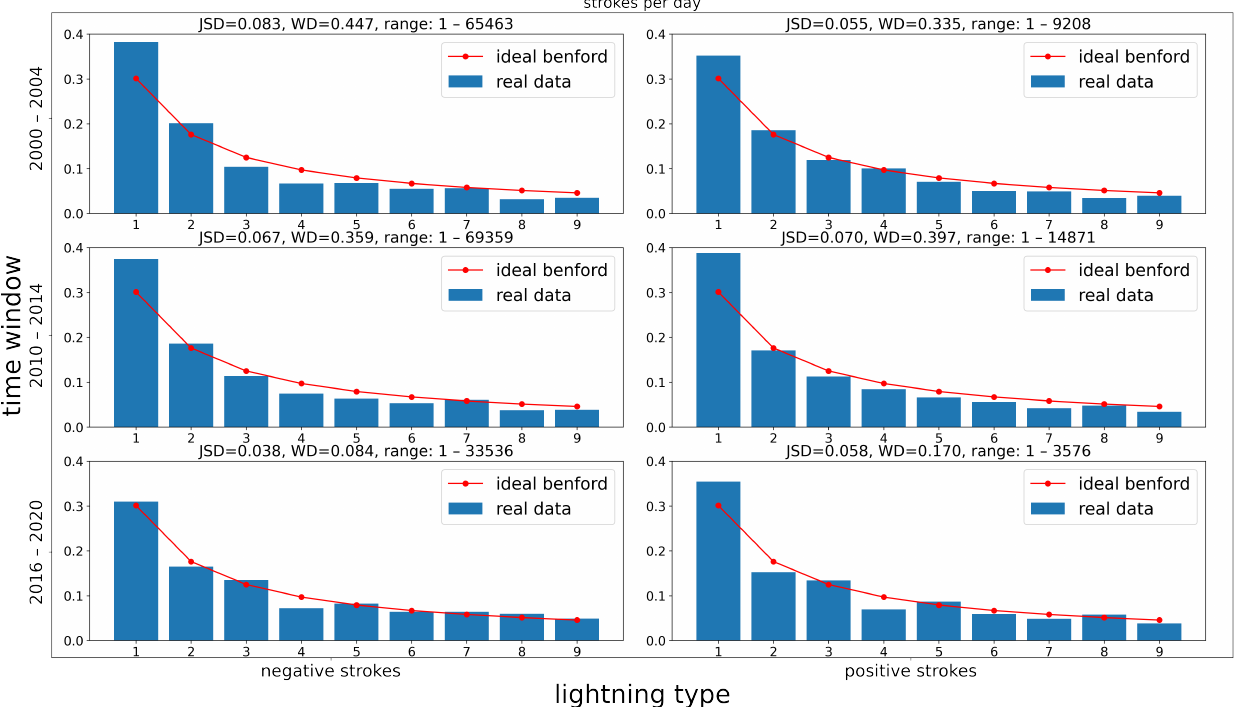
Figure 5. First digit distribution of data versus Benford. These figure show the frequency of the most significant digit of lightning data in blue compared to the expected probability distribution dictated by Benford’s law in red. The left column depicts the negative strokes data and the right one represents the positive ones. Furthermore, rows represent the three time windows, from top to bottom : 2000– 2004, 2010–2014, 2016–2020. Jensen–Shannon distance (JSD), Wasserstein distance (WD), and range of data is provided on the top of each